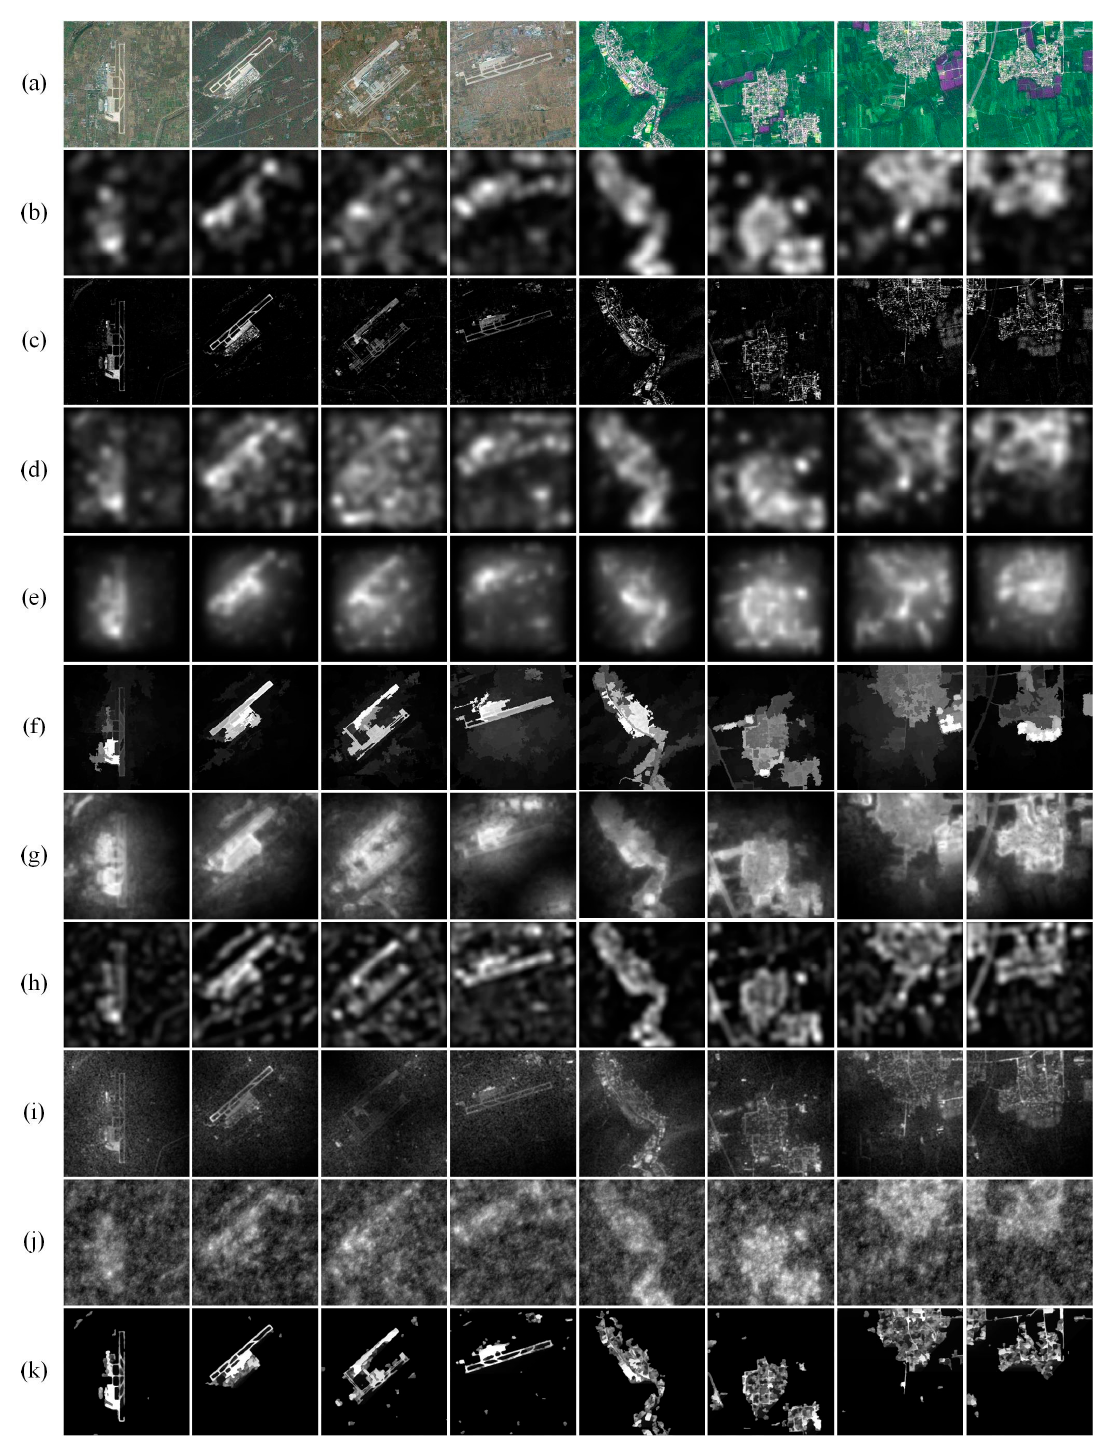
Figure 10. Comparison of saliency maps for images polluted by Gaussian noise (Standard Variance = 0.01) (first four images are from the SPOT5 satellite and last four are from Google Earth): ( a ) remote sensing image; ( b ) SR; ( c ) FT; ( d ) ITTI; ( e ) GBVS; ( f ) H; ( g ) CA; ( h ) FDA; ( i ) WT; ( j ) MFF; and ( k ) LI.